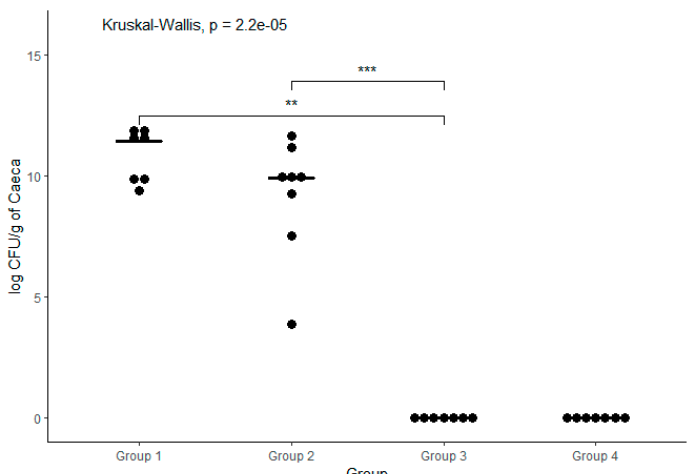
Figure 1. Levels of C. jejuni M1 in caecal contents of broiler chickens 8 days post-challenge. Group 1 were challenged by oral gavage; Group 2 were challenged by feeding with infected Galleria mellonella larvae. Groups 3 and 4 were control groups, given PBS delivered either by Galleria mellonella larvae (Group 3) or oral gavage (Group 4). Group sizes were N = 7 for groups 1, 3 and 4 and N = 8 for group 2 (** p < 0.05, *** p <